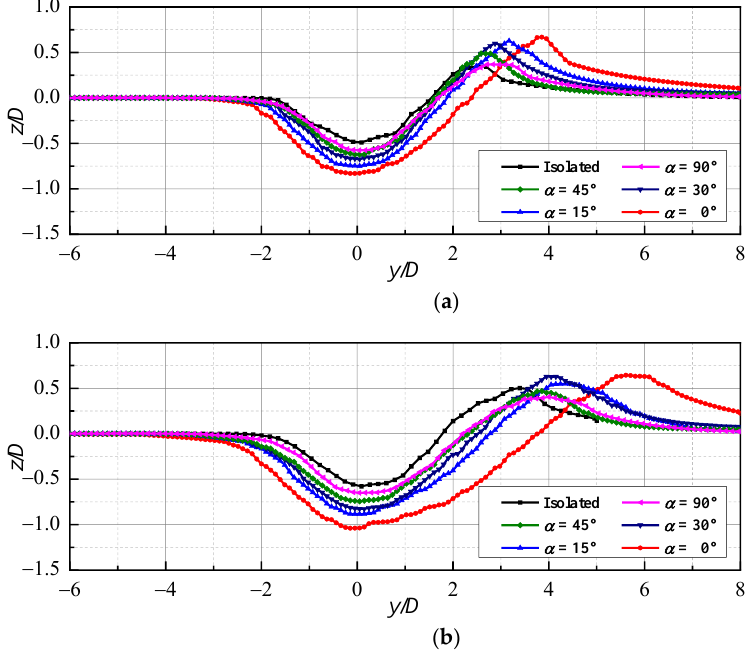
Figure 8. The scour profiles for different intersecting angles: ( a ) t = 300 s; ( b ) t = 900 s.